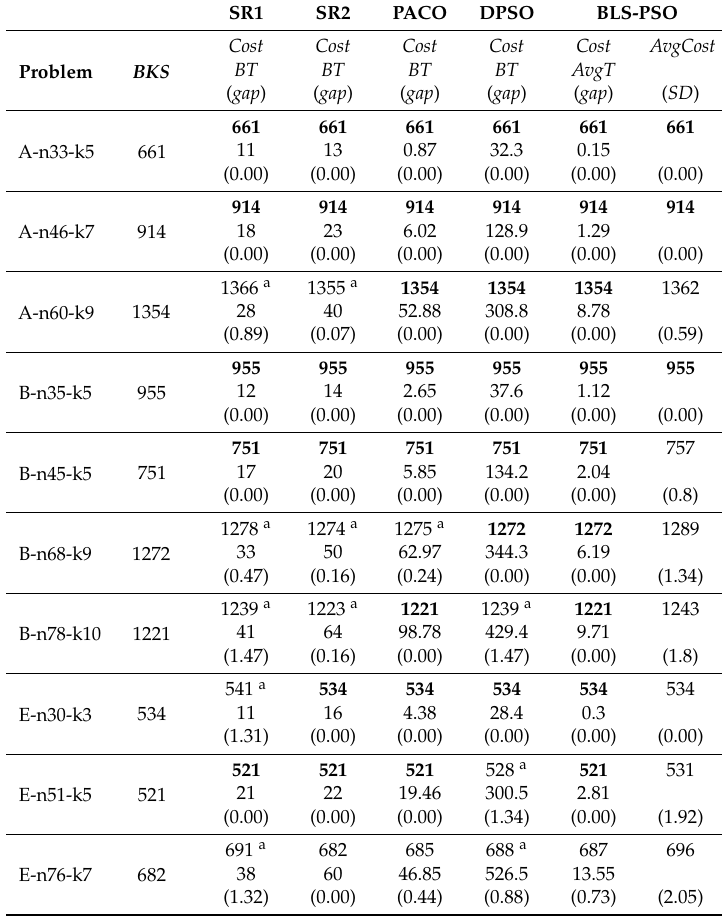
Table 11. Performance comparison of BLS-PSO with respect to other PSO-based approaches for solving some selected